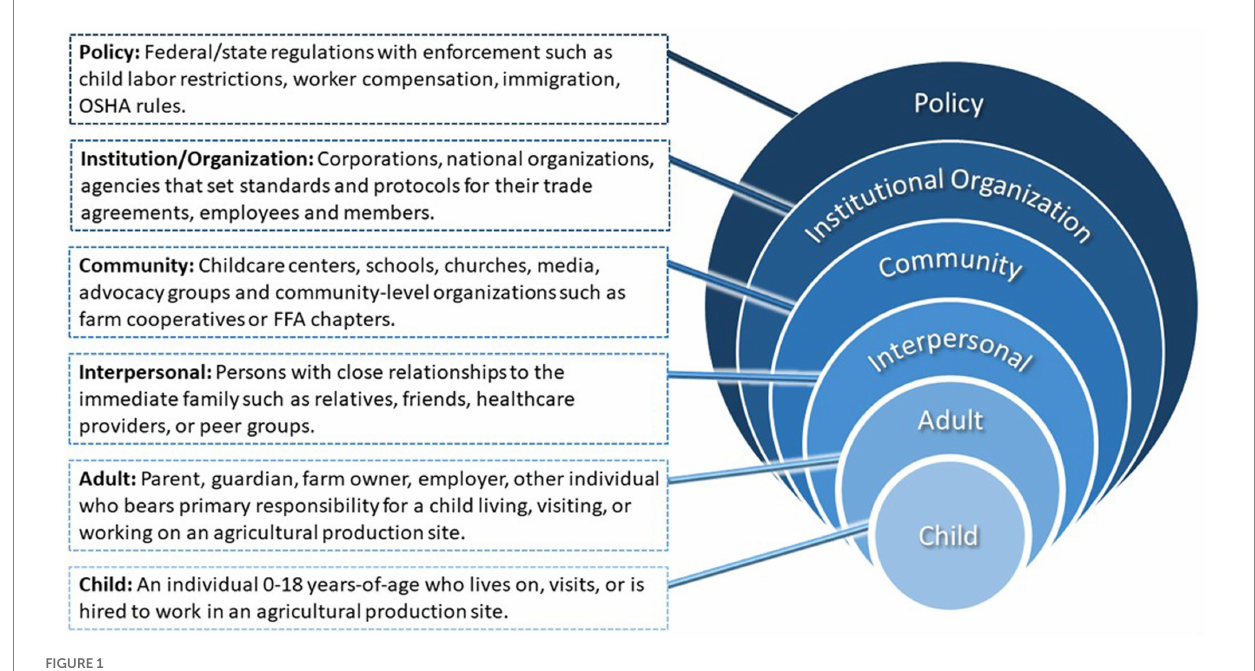
FIGURE 1 Socio-ecological model (modified for